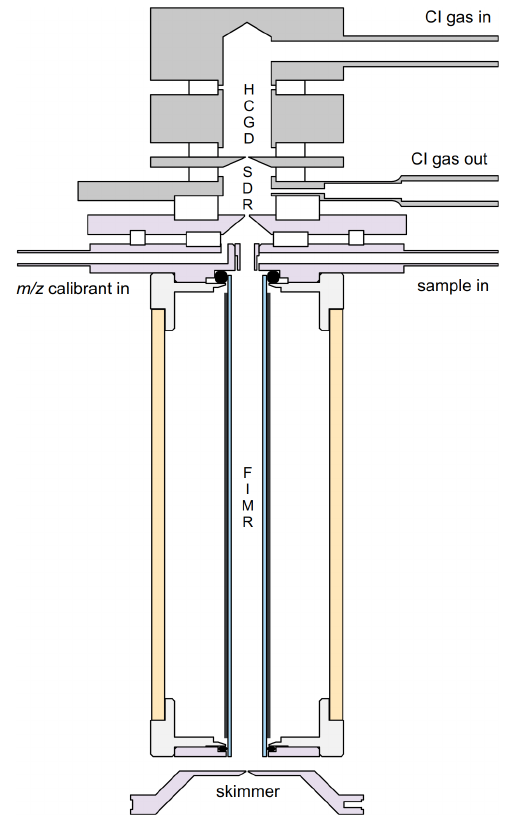
Figure 1. Schematic drawing of the new prototype PTR-ToF-MS analyzer. The instrument consists of a hollow cathode glow dis- charge (HCGD) ion source, a source drift region (SDR) and a fo- cusing ion–molecule reactor (FIMR), which is a resistive glass drift tube surrounded by cylindrical quadrupole